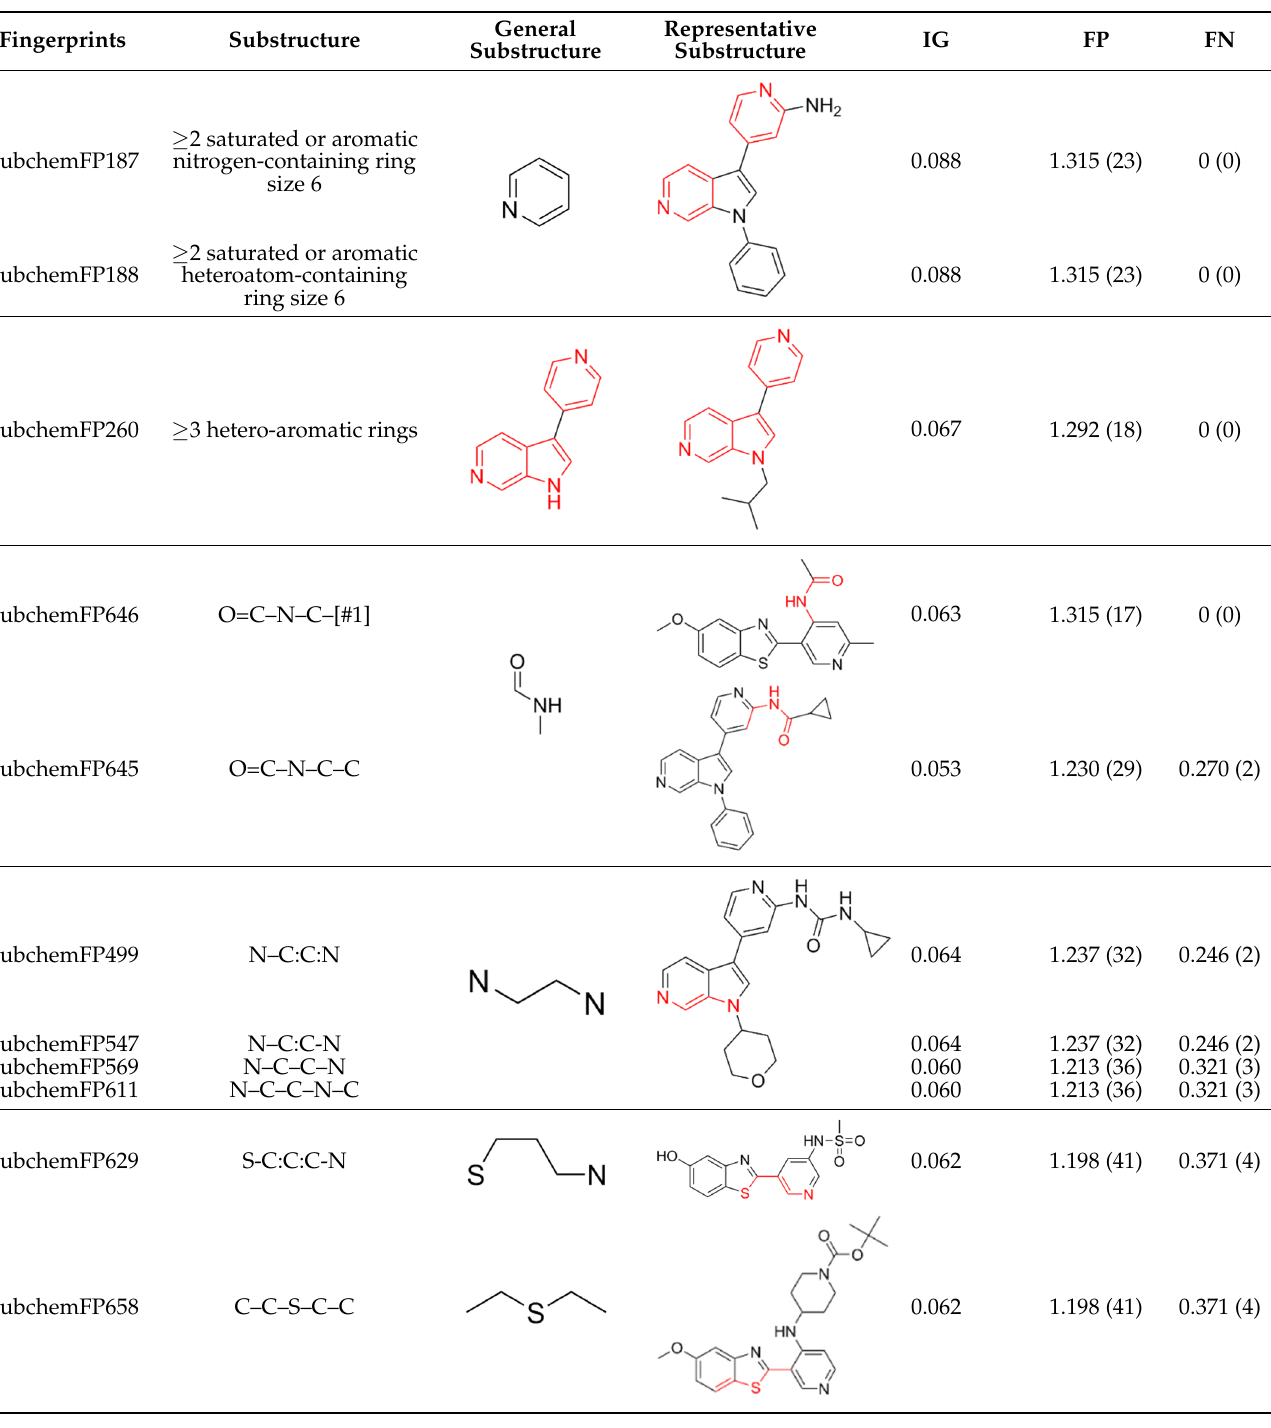
Table 3. PubChem fingerprint-based privileged substructures responsible for DYR1KA inhibition.